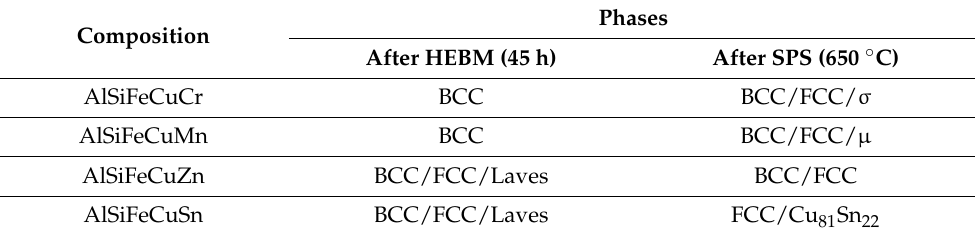
Figure 2. ( a ) XRD analysis of the SPSed AlCuSiFeX (X = Cr, Mn, Zn, Sn) HEAs and ( b ) magnified view of ( a ). Table 1. Phase evolution after HEBM and SPS from XRD analysis.